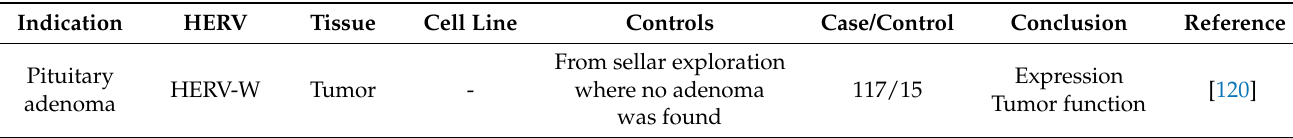
Table 12. HERV protein expression in endocrine cancers.